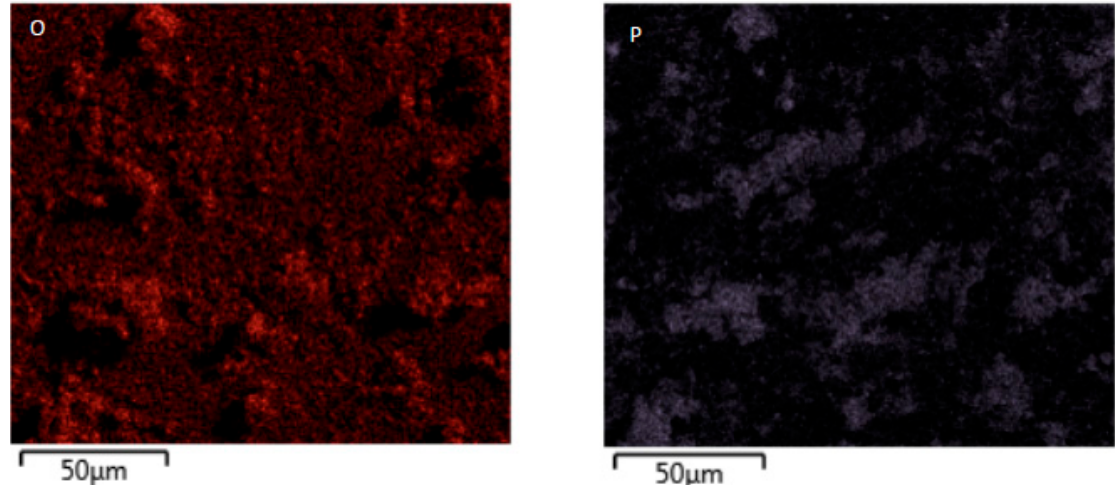
Figure 2. Representative electron image for EDS analysis of HA-GO-2.0% composite showing wide distribution of three important elements including carbon (C) as a representation of graphene, calcium (Ca) and phosphorus (P) evidencing the inclusion of HAP.